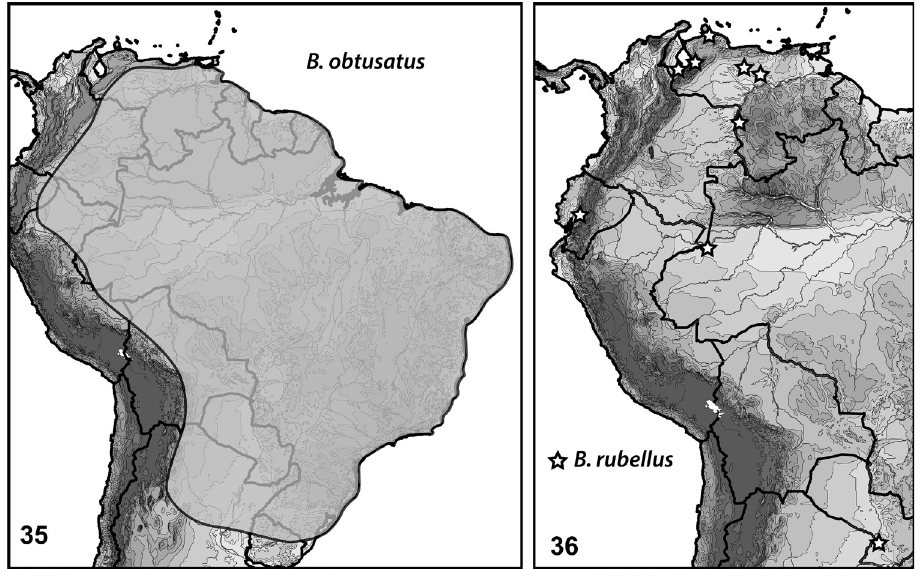
Figures 35–36. Bidessonotus species, South American